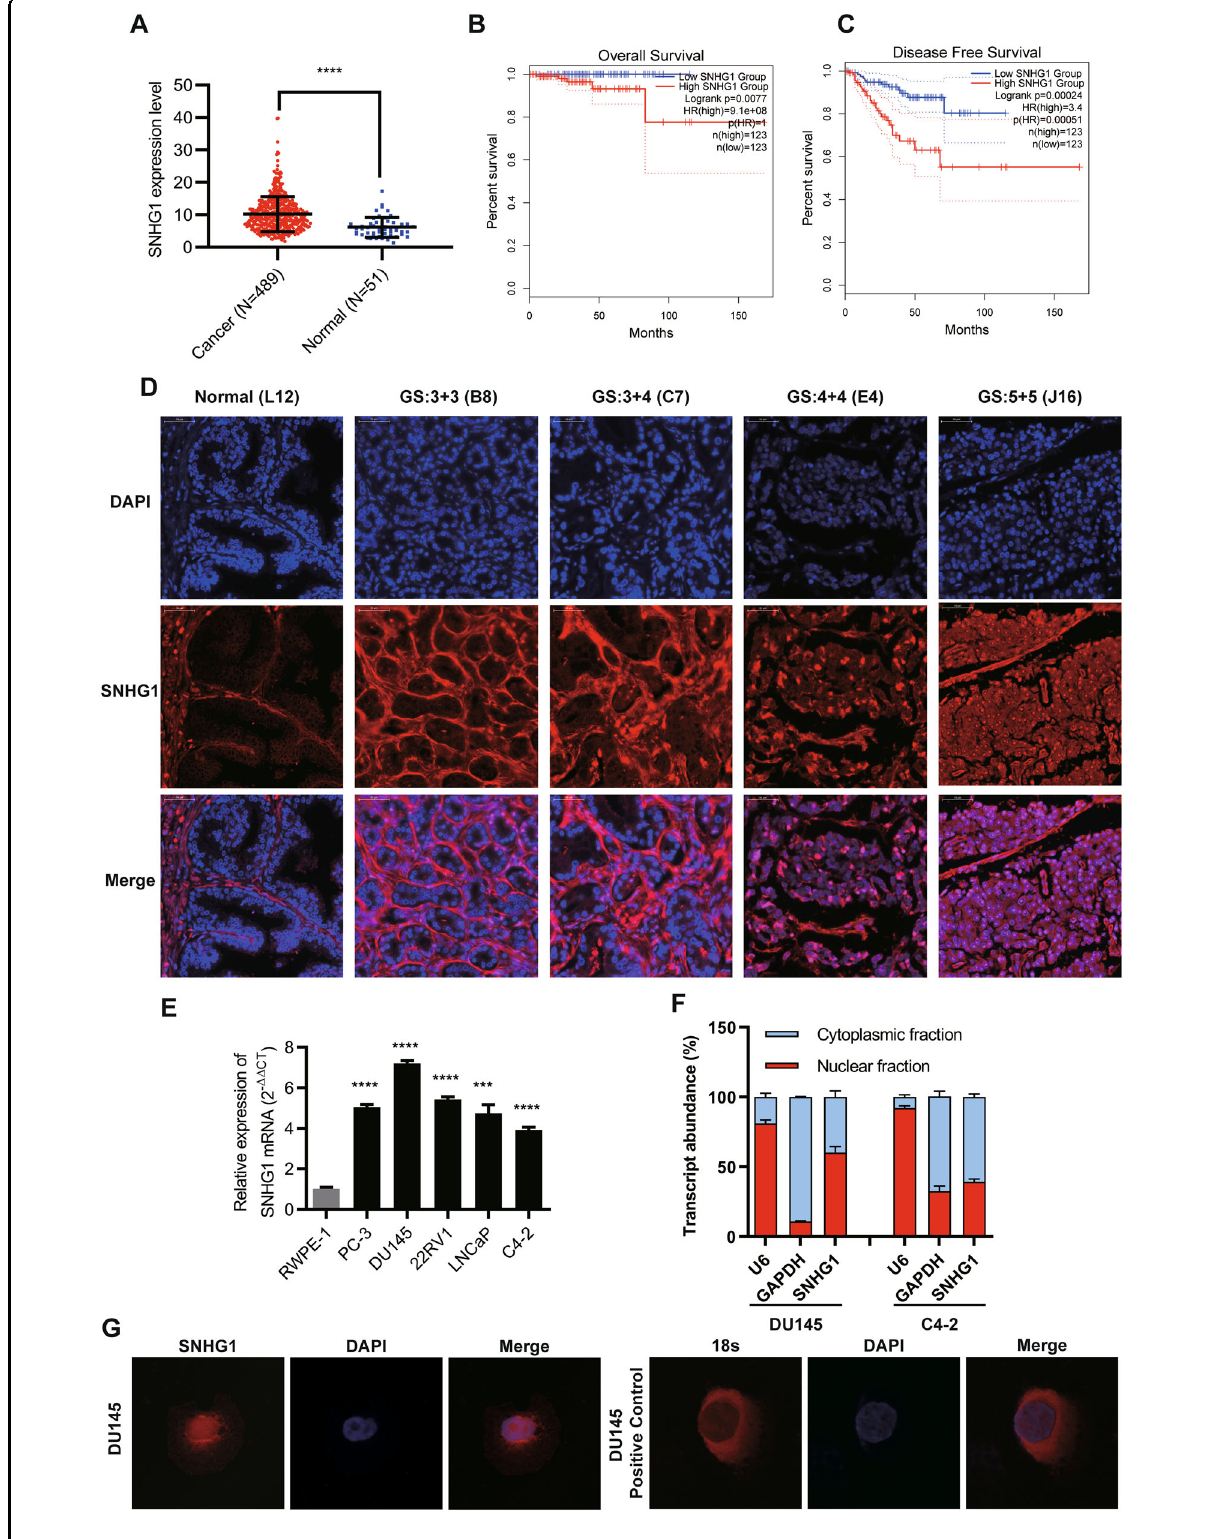
Fig. 1 (See legend on next